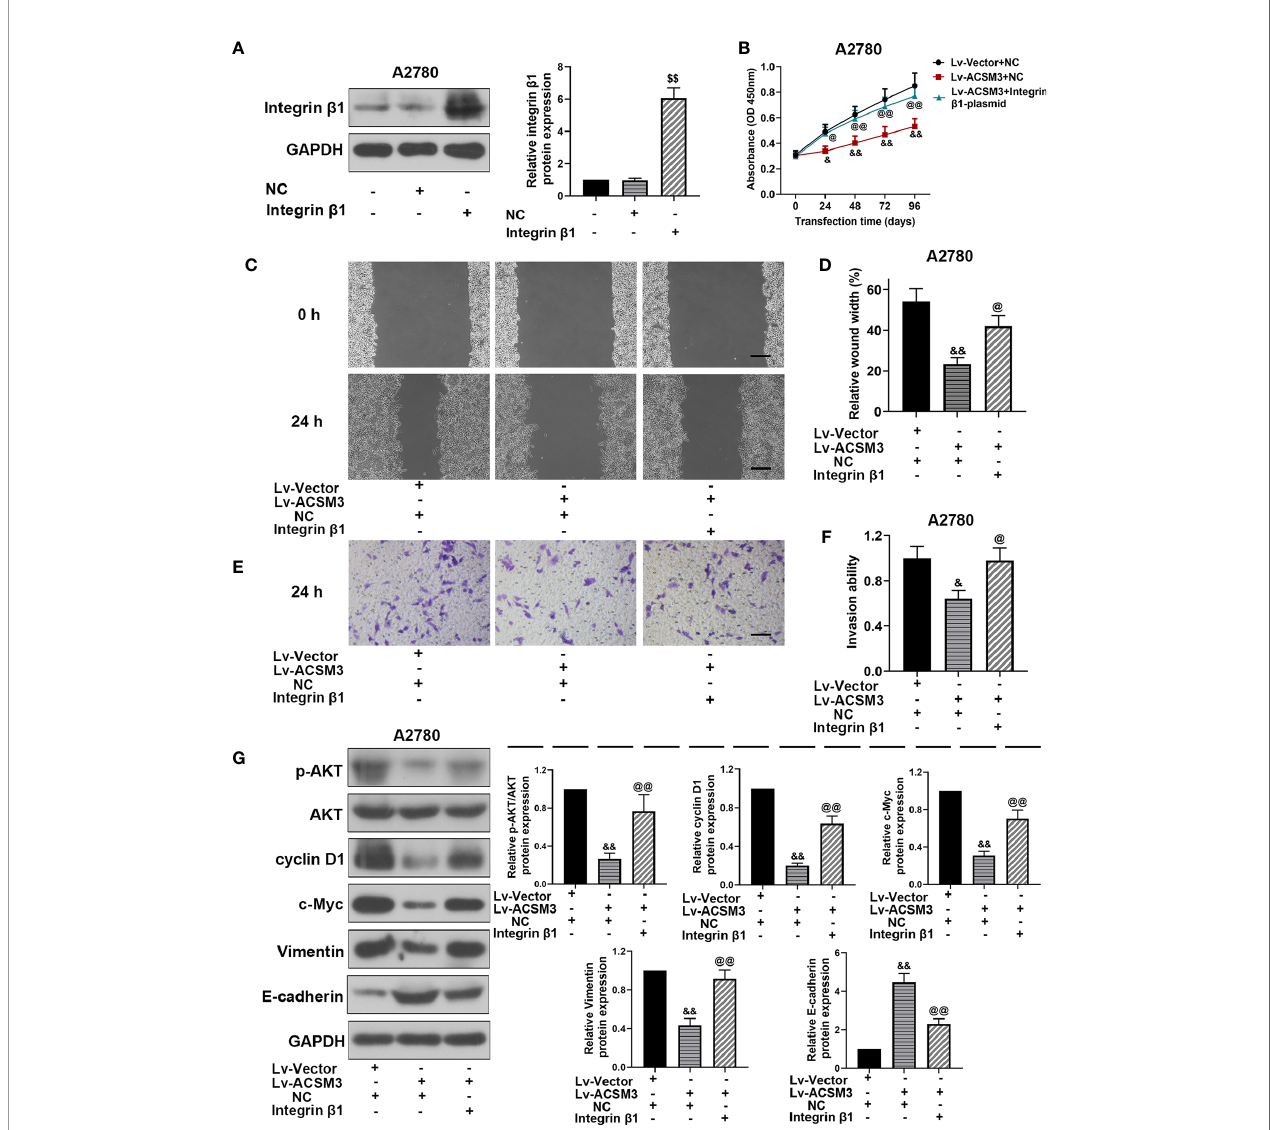
FIGURE 5 | Effects of overexpressed ITG b 1 (Integrin b 1) on ACSM3 up-regulated ovarian cancer cells. (A) The protein expression of Integrin b 1. (B) ACSM3 up- regulated A2780 cells were transfected by ITG b 1 (Integrin b 1) overexpression vector and were subjected to CCK-8 assay. (C, D) Relative wound width (Scale bar represented 200 m m). (E, F) Invasion ability. Scale bar represented 100 m m. (G) Relative protein expression of p-AKT, AKT, cyclin D1, c-Myc, Vimentin, and E- cadherin. Measurement data were expressed as mean ± SD of three independent experiments. $$ p < 0.01 versus NC; & p < 0.05, && p < 0.01 versus Lv-Vector+NC; @ p < 0.05, @@ p < 0.01 versus